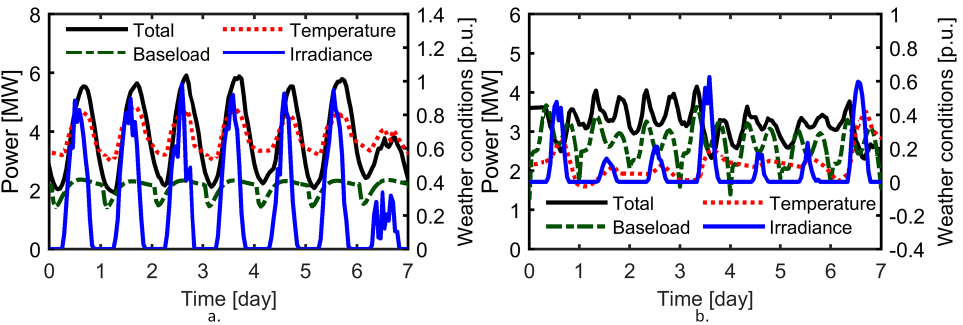
Figure 6. Baseload power estimated for summer ( a ) and winter ( b ) example weeks plotted for reference together with the total measured power and the weather conditions from Figure 5. The difference between the two powers provides the component corresponding to the HVAC